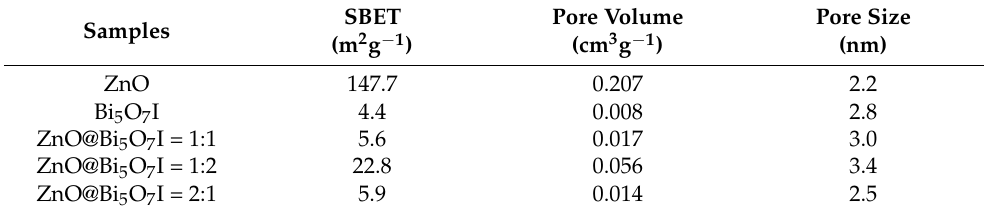
Figure 3. N 2 adsorption and desorption isotherms.